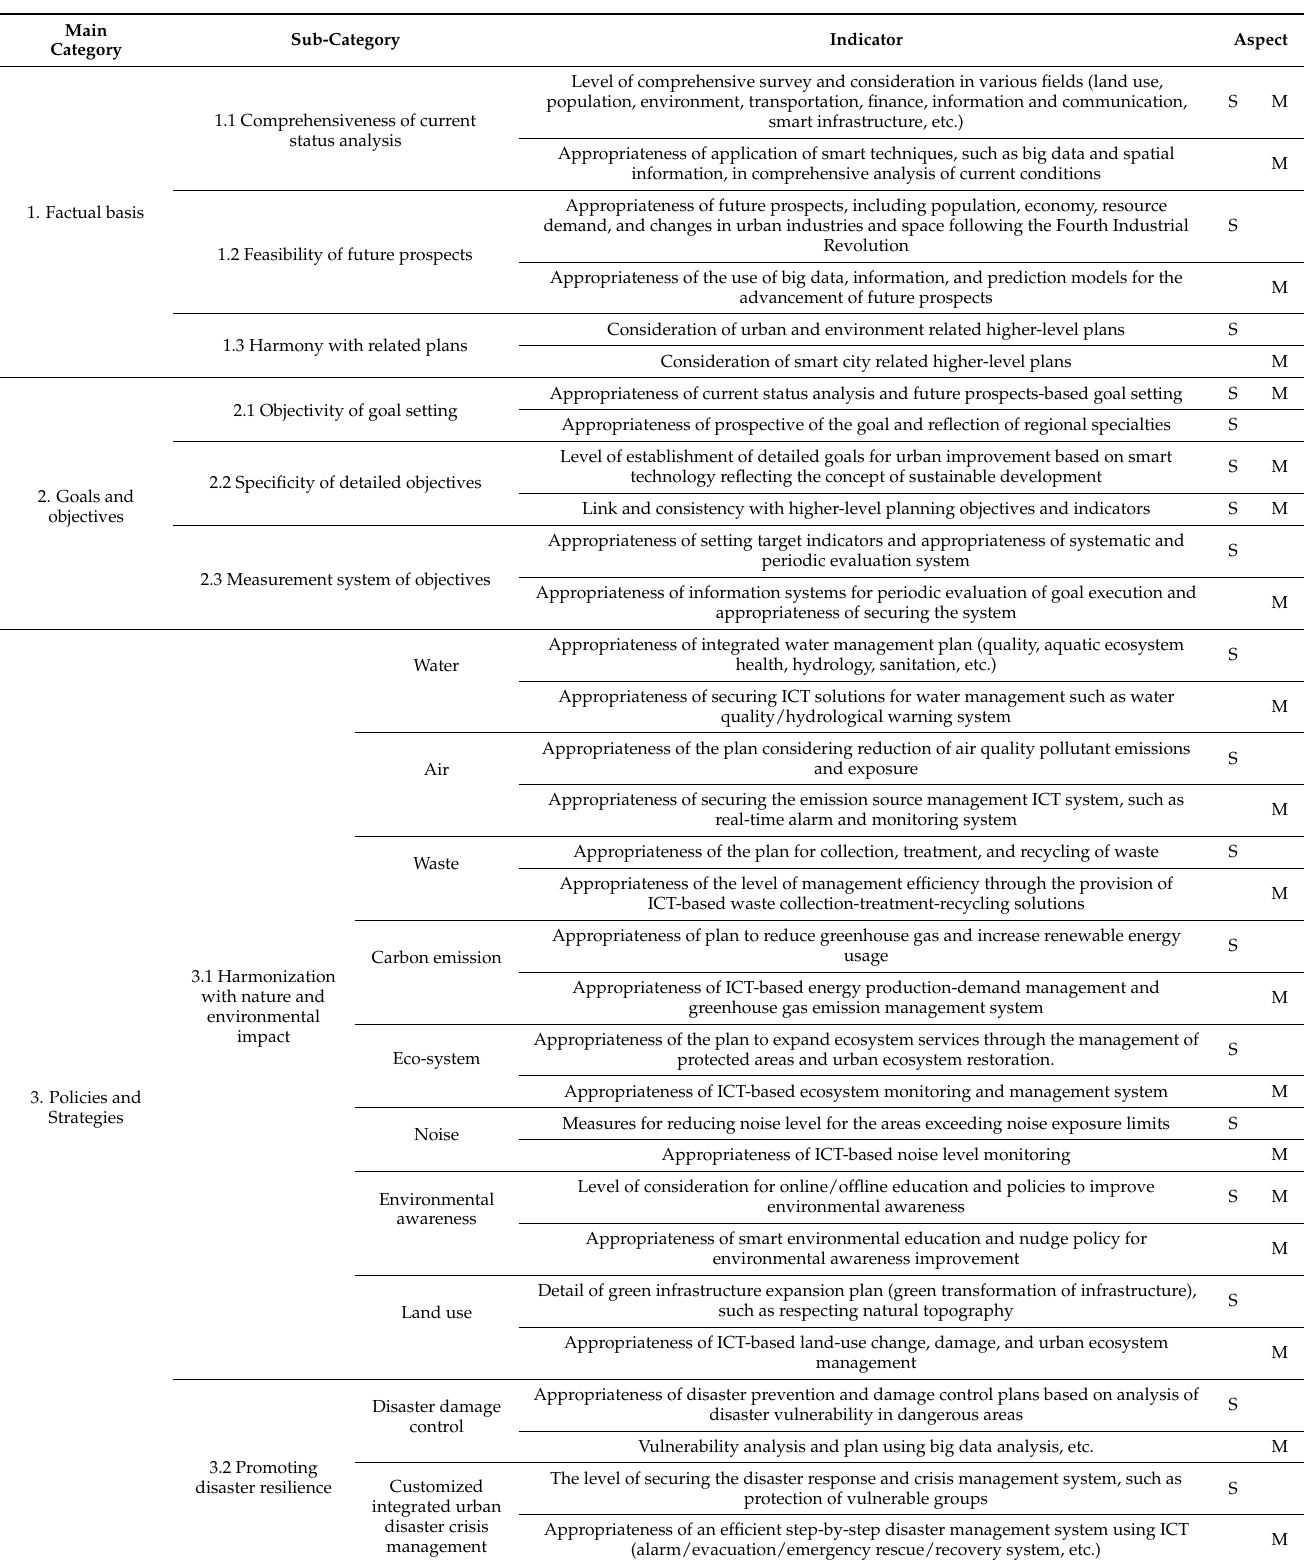
Table 1. Smart sustainable city evaluation and diagnosis